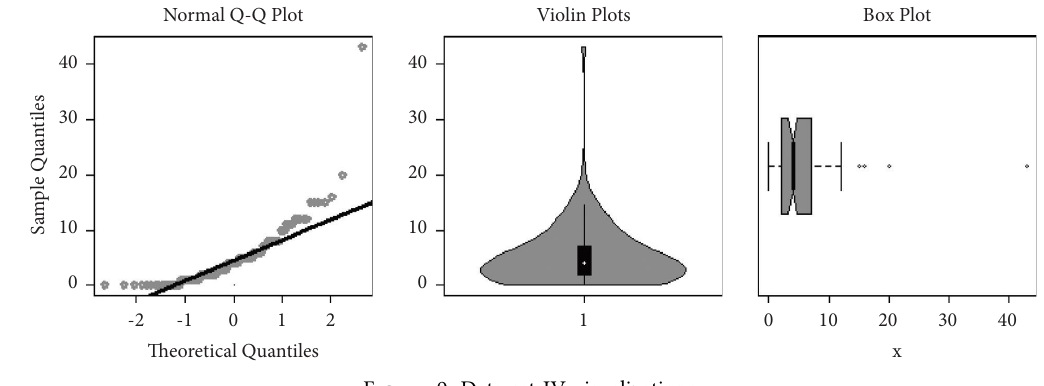
Figure 9: Data set IV visualizations. Table 15: Te MLE, SE, and CI of the tested models based on data set IV.